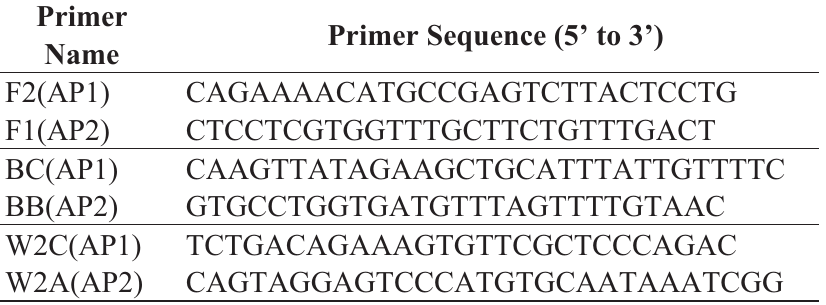
Table 2. Nested primers for PCR based walking